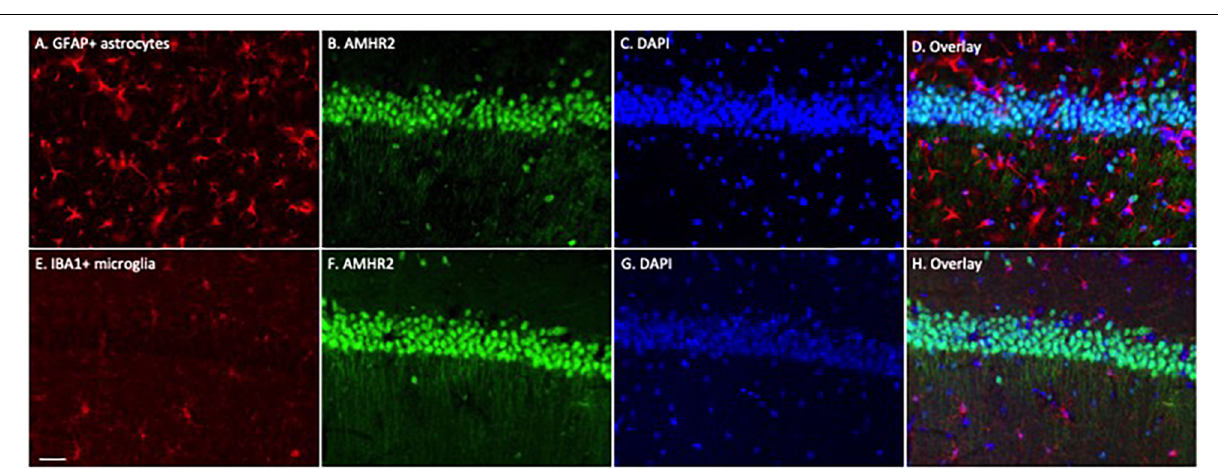
Frontiers in Neuroscience |